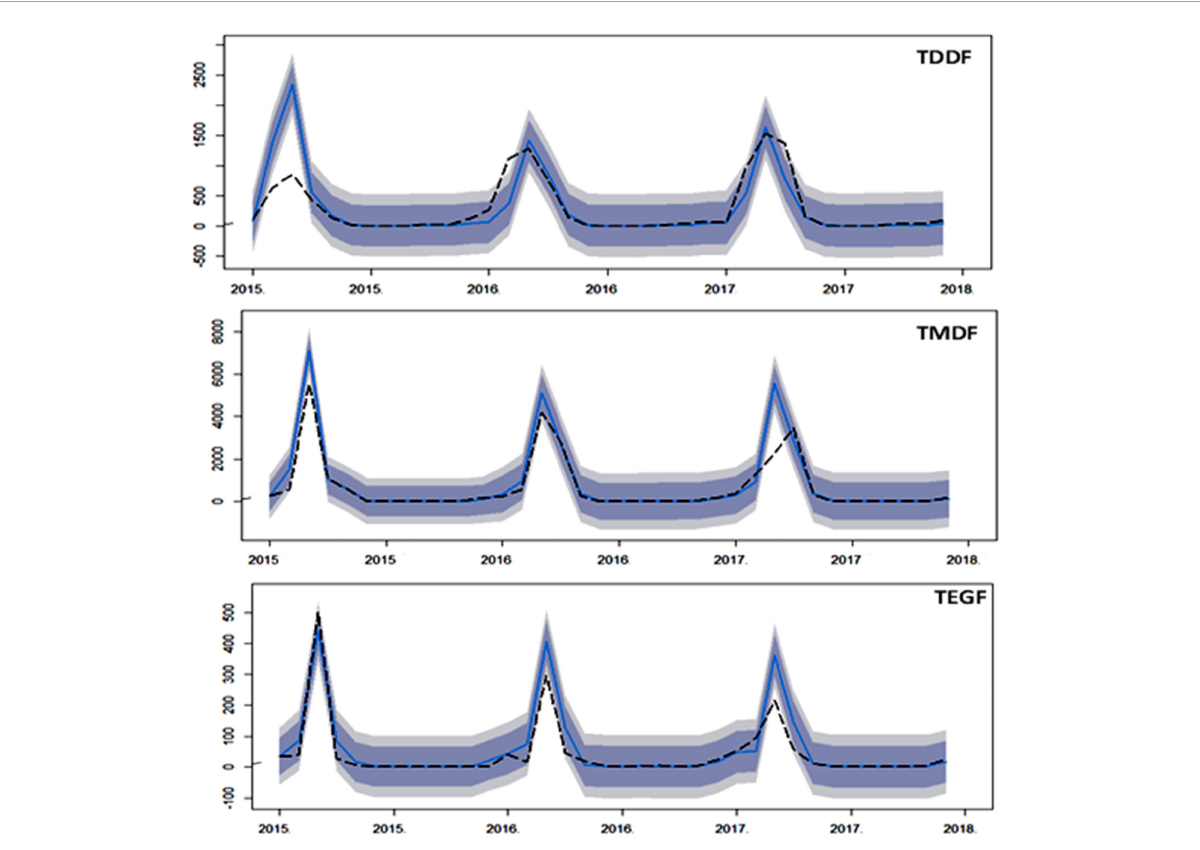
FIGURE7 Comparison of ARIMA univariate model forecast, with test data (2015–2017) for Tropical Dry Deciduous Forests (TDDF) Tropical Moist Deciduous Forests (TMDF) and Tropical Evergreen Forests (TEGF). The dashed line depicts the original values, solid blue line depicts forecasted values and shaded area depicts prediction interval (inner to outer 80 and 95%,